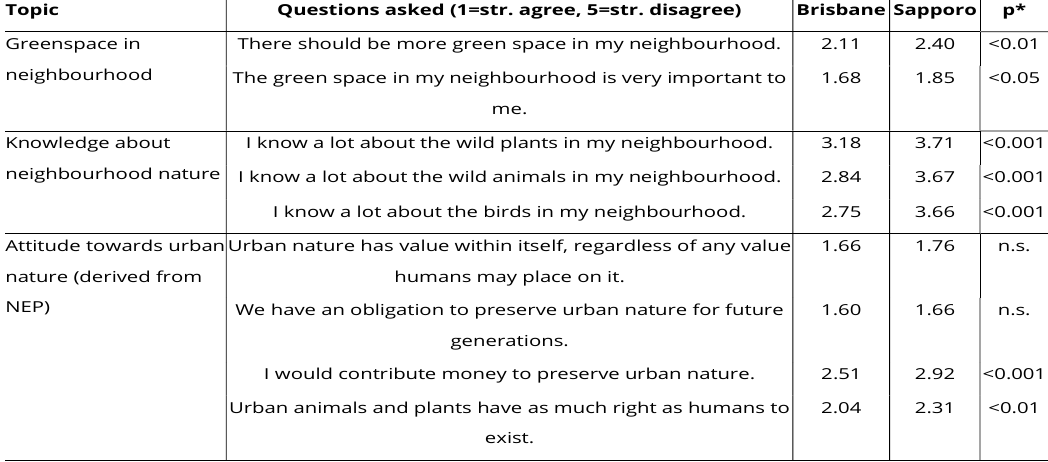
Table 3. Means of residents’ views on close greenspace, their knowledge about nature, and disposition towards urban nature (adopted from Rupprecht et al.